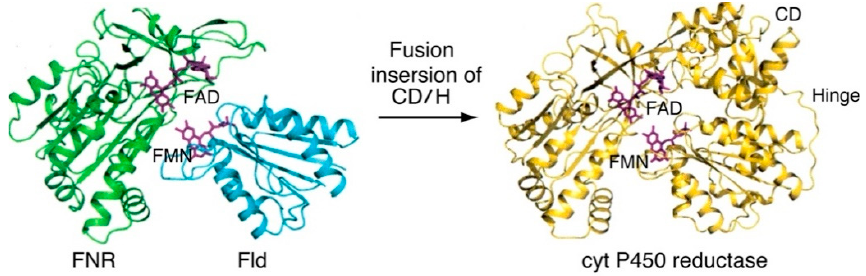
Figure 9. Evolutionary origin of the cyt P450 reductase: ( left ) plant FNR and bacterial Fld redox complex and ( right ) cyt P450 reductase. CD/H indicates the connecting domain (CD) and the hinge (H) [12,14].